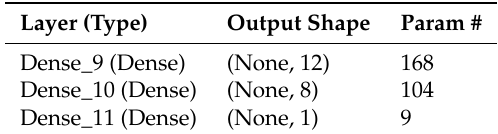
Table 4. Keras model